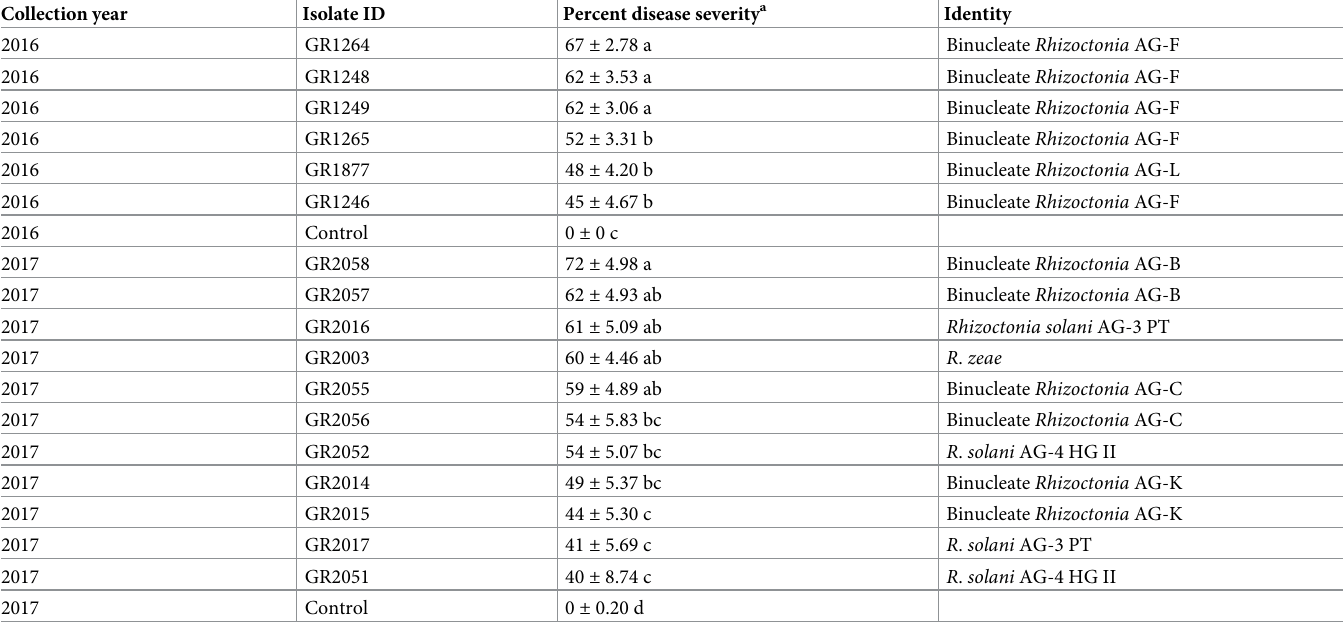
Table 2. Pathogenicity of Rhizoctonia spp. isolates from grasses assessed on soybean line CR2603 in rolled towel bioassay. Isolates collected in 2016 and 2017 were evaluated in separate experiments.